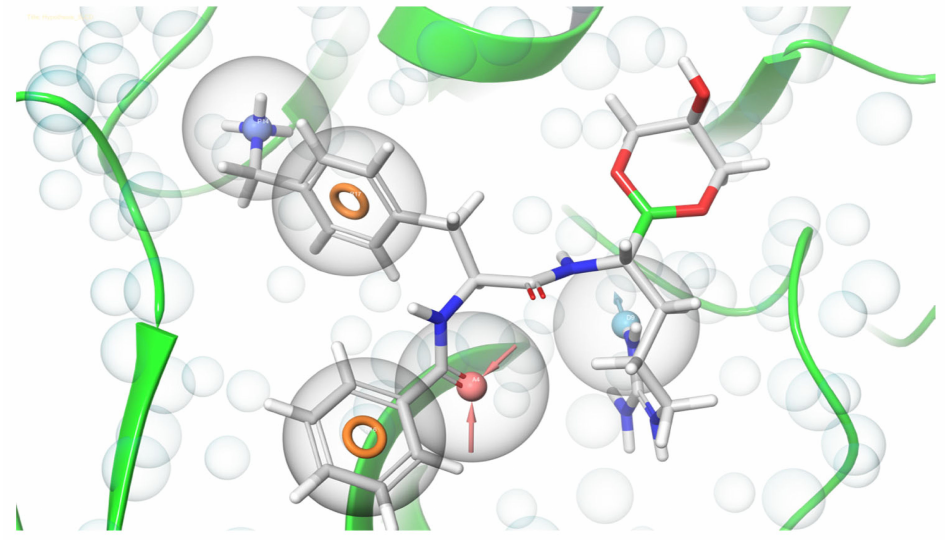
Figure 1. The e-pharmacophore model of NS2B-NS3 protein of ZIKV with boronate inhibitor showing one hydrogen bond acceptor (A), one hydrogen bond donor (D), one positively ionic (P) and two aromatic rings structures